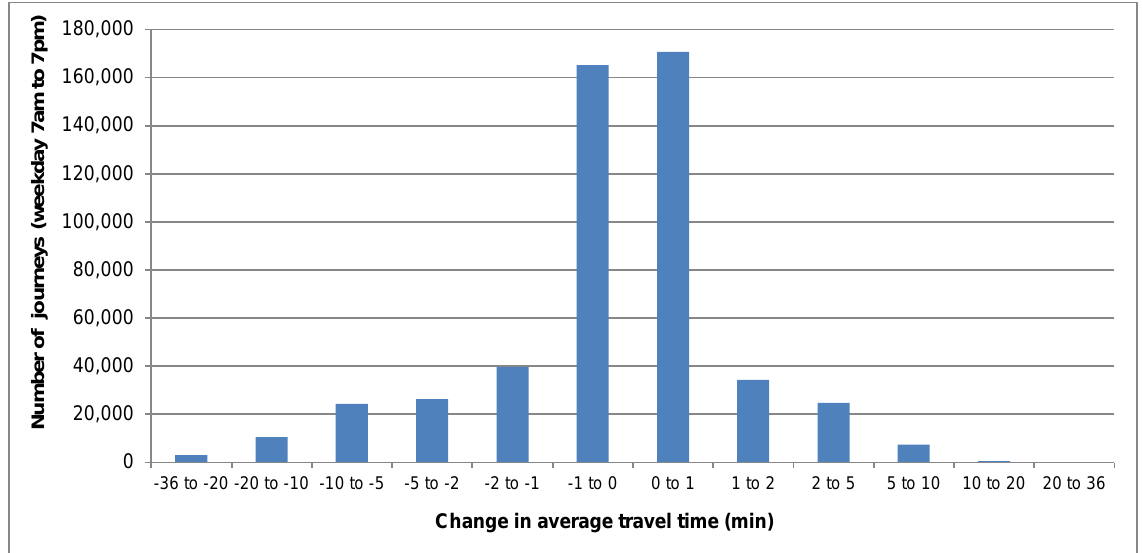
Figure 8. Distribution of travel time savings and losses over